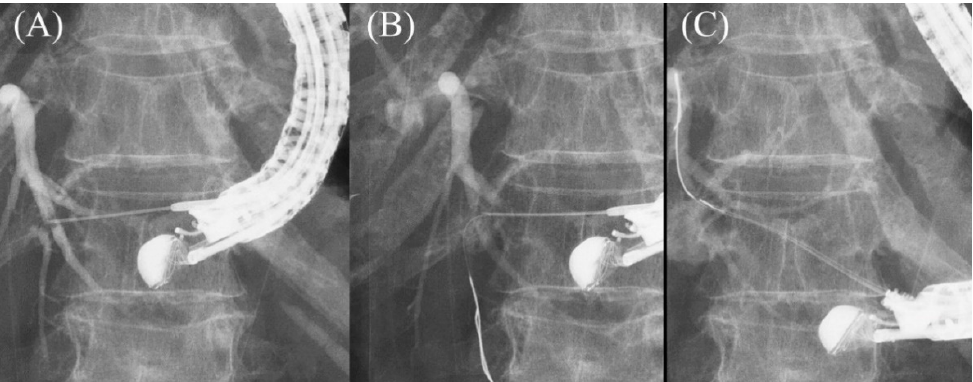
Figure 11. Moving scope technique for redirection of a guidewire. If a guidewire is unintentionally advanced to the peripheral side ( A , B ), push the scope while turning the large wheel upward to change the needle direction to the cranial side, allowing the guidewire to proceed toward the hilum ( C ).